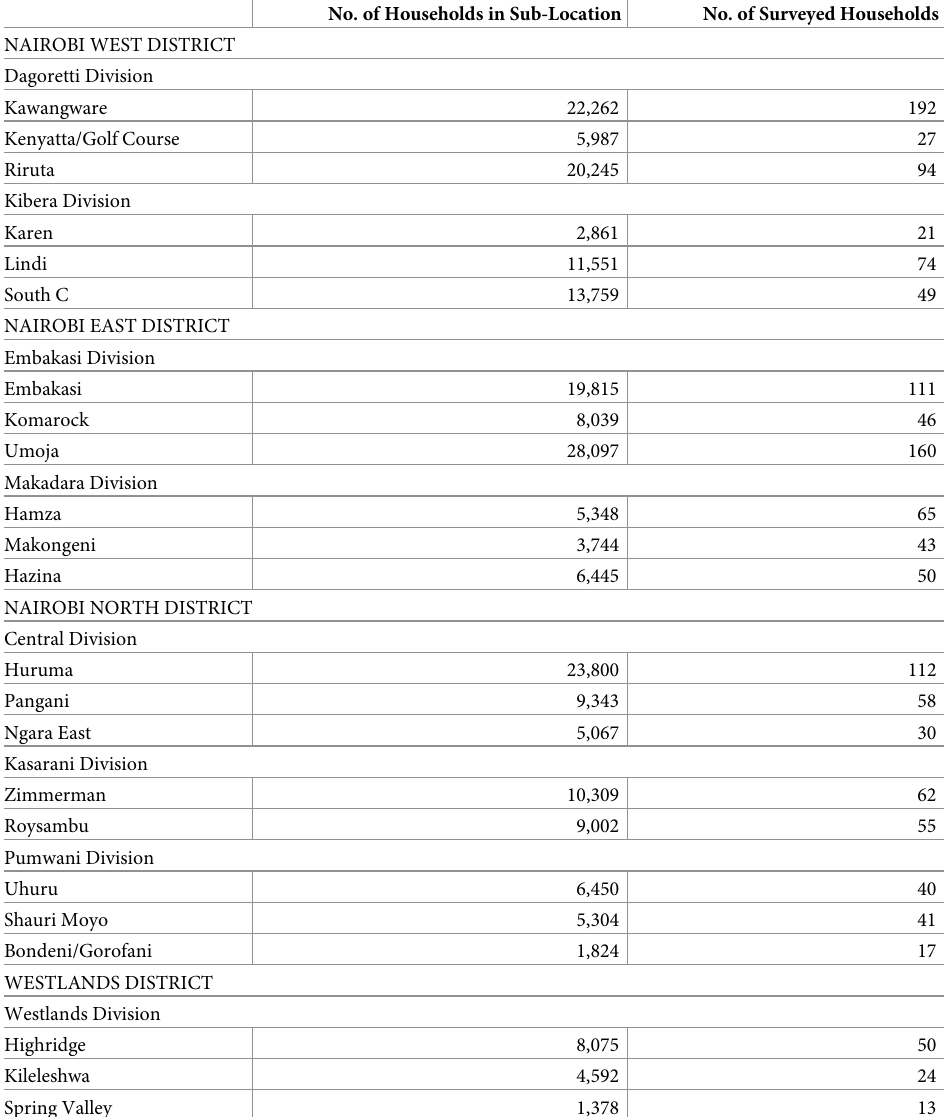
Table 1. Number of surveyed households by